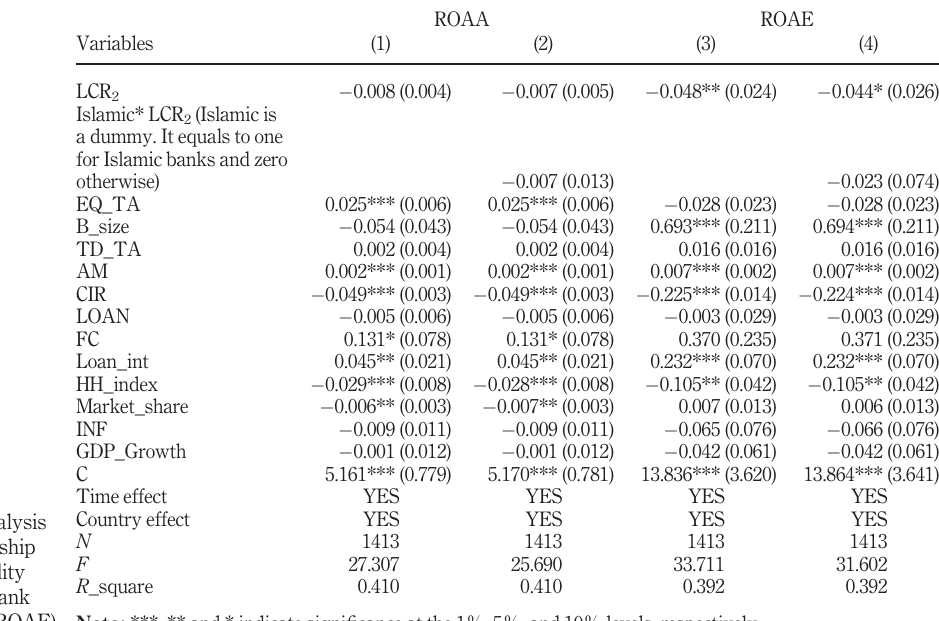
Table VII. Regression